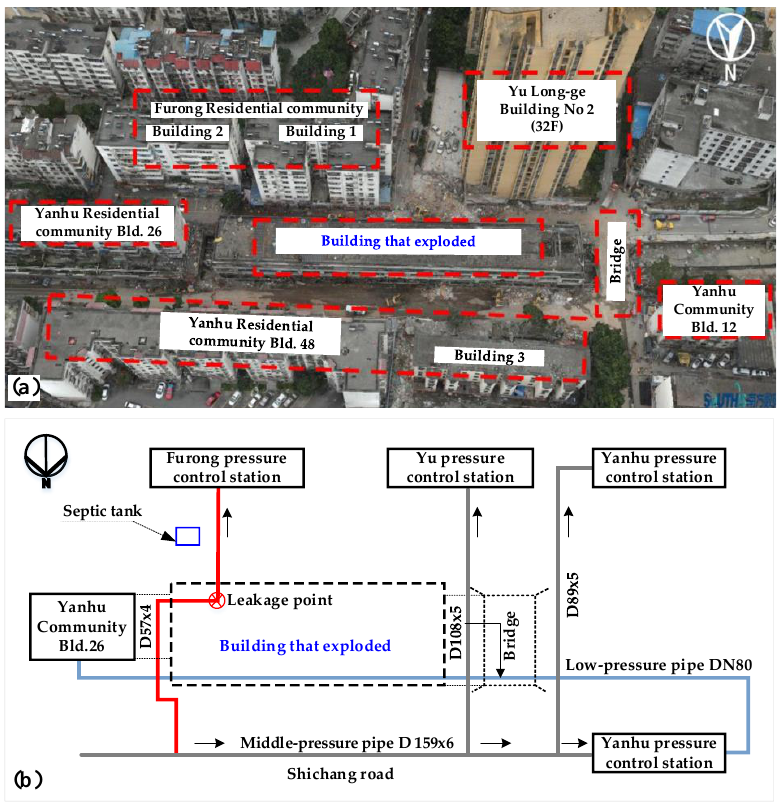
Figure 2. Main buildings and gas pipelines involved in the explosion (Recreated after [21]). ( a ) Surrounding buildings affected by the explosion. ( b ) Gas pipelines arrangement and leakage point.